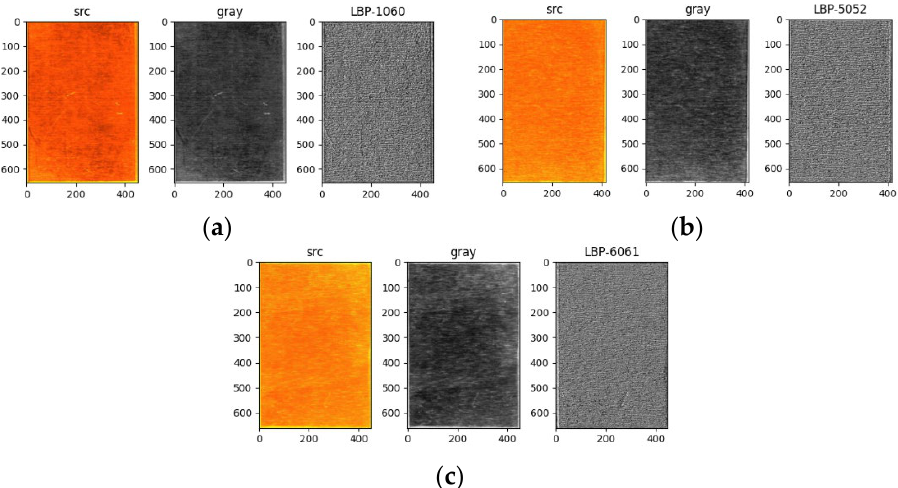
Figure 8. ( a ) Feature image of 1060; ( b ) Feature image of 5052; ( c ) Feature image of 6061.